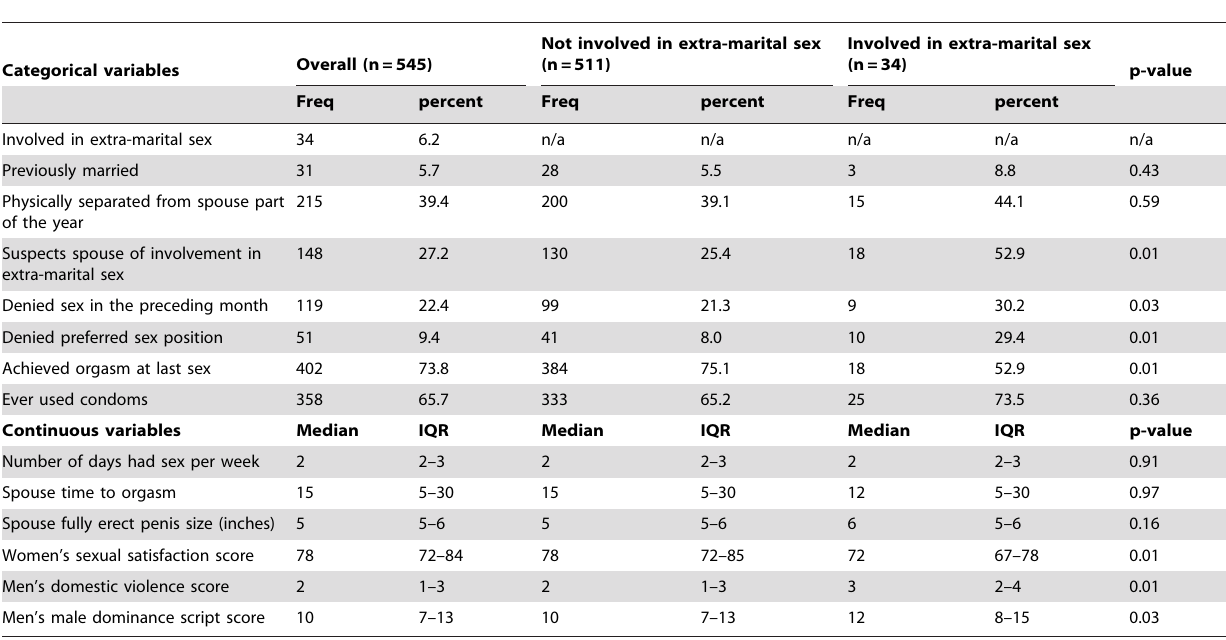
Table 2. Relationship and sexual attributes by extra-marital partnership status among women married to fishermen along Lake Victoria in Kisumu